Question: State the chart type depicted above.
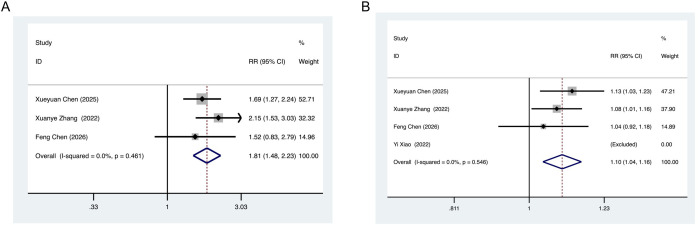
Answer: forest